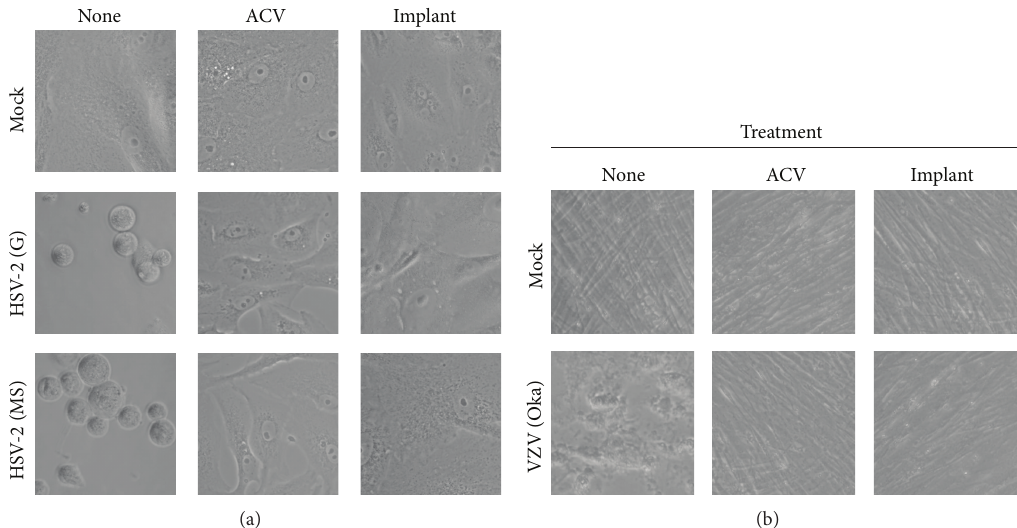
Figure 1: In vitro antiviral activity of silicone implants impregnated with ACV against HSV-2 and VZV. (a) Vero cells were grown to near- confluence and received either medium alone (“None”), acyclovir (0.22 𝜇 g/mL), or an acyclovir-containing silicone implant (MED-4050). One day later, wells were inoculated with either complete medium alone (“Mock”), 95pfu of HSV-2 (G), or 95 pfu of HSV-2 (MS). Digital photos were taken 3 days after infection. This experiment was performed six times; representative wells are shown. Each implant was prepared by mixing polymer component A, polymer component B, and ACV in a 1:1:1 ratio as described in Section 2. (b) MRC-5 cells were grown to near-confluence and received either medium alone (“None”), acyclovir (10 𝜇 g/mL), or an acyclovir-containing silicone implant (MED-4050). Two days later, wells were inoculated with either buffer alone (“Mock”) or 150pfu of VZV. Digital photos were taken 10 days after infection. This experiment was performed three times; representative wells are shown. Each implant was prepared by mixing polymer component A, polymer component B, and ACV in a 1: 1:1 ratio as described in Section